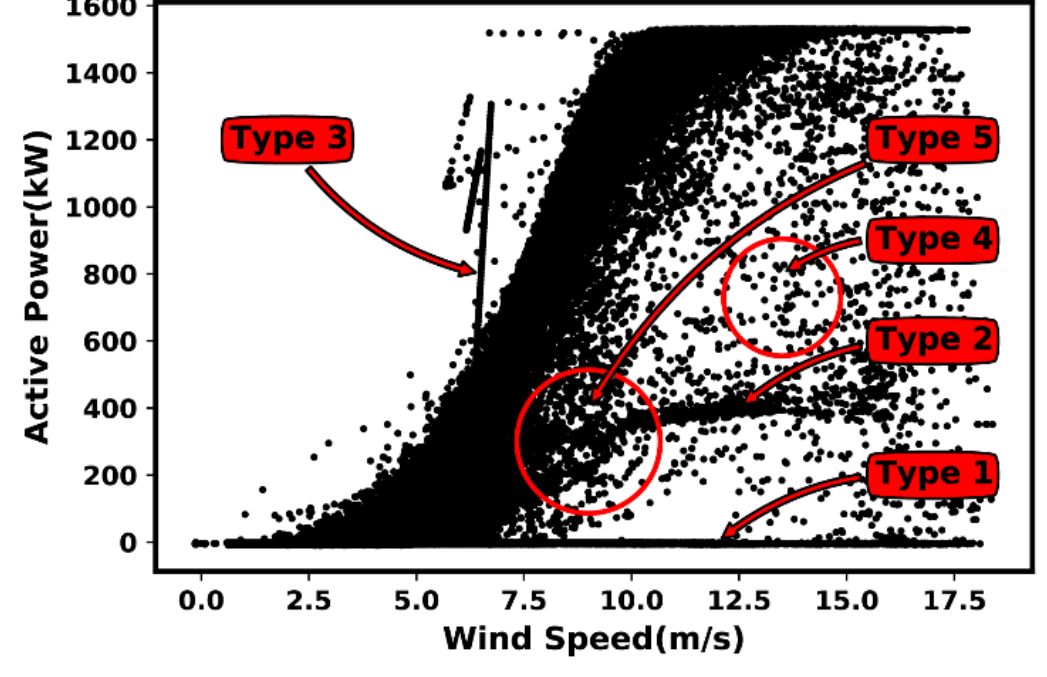
Figure 5. Wind turbine “ actual power curve ” marked with anomaly and fault signatures [21].